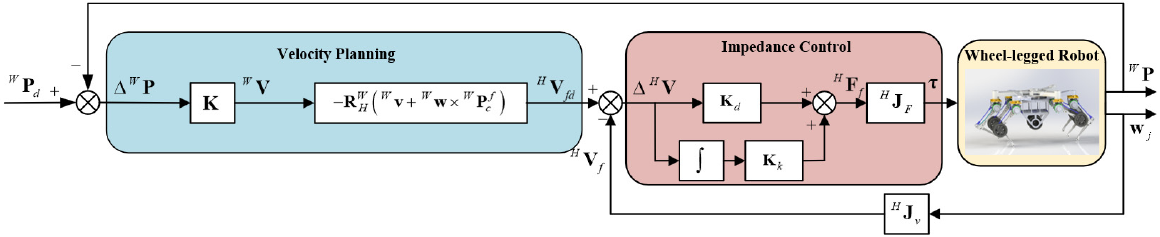
Figure 4. Control block diagram of the stance phase. The control block diagram has two main sub-blocks: sub-block of velocity planning and sub-block of impedance control. The sub-block of velocity planning plans the desired velocity of the torso and the desired velocity of the foot. The sub-block of impedance control calculates the torque of joints to control the wheel-legged robot to execute the desired motion.